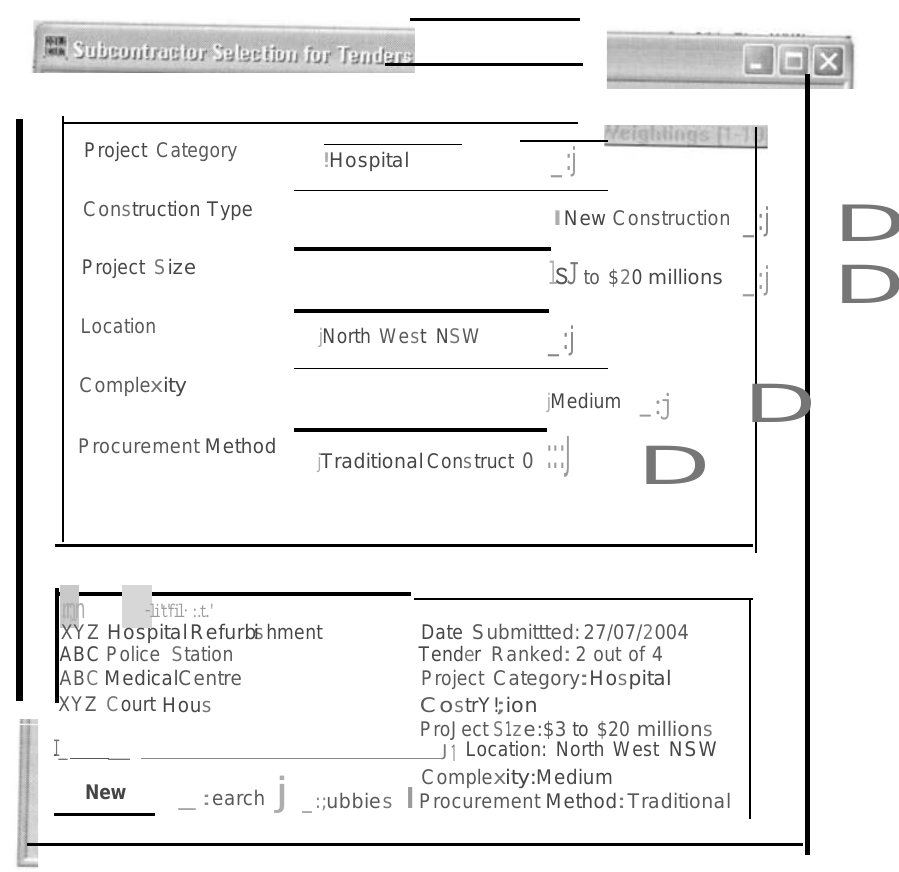
Figure 3: Case Representation in